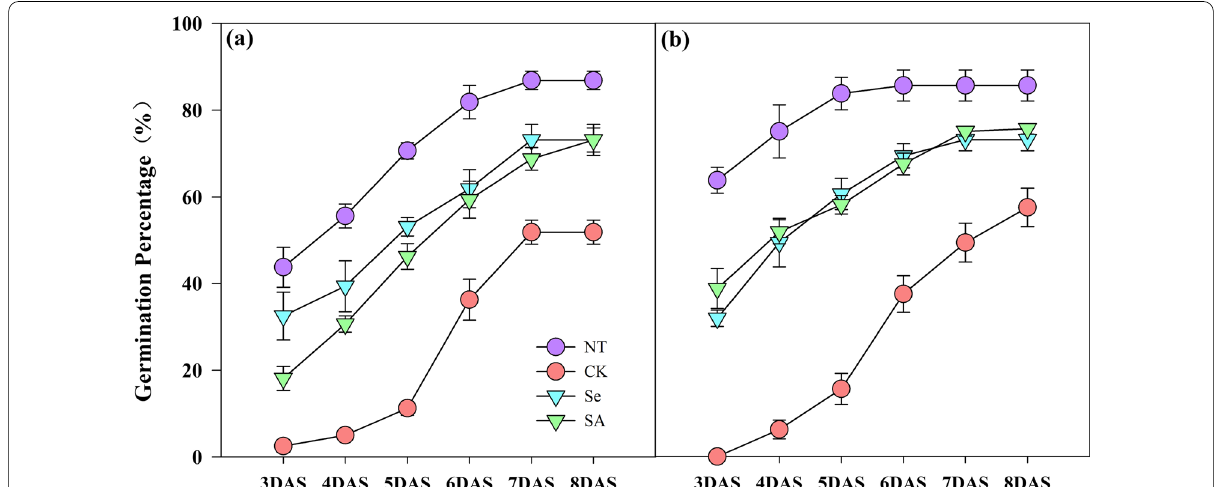
Fig. 1 Germination dynamics of primed and non-primed rice seeds under control temperature and chilling stress. a EZ18. b LY287. DAS, days after sowing; EZ18, ezao18; LY287, liangyou287; NT, no priming-normal temperature control; CK, no priming-chilling stress; Se, Selenium priming-chilling stress; SA, Salicylic priming-chilling stress. Seed germination data was recorded from 3DAS till constant at 8 DAS. Error bars indicate standard error (n =